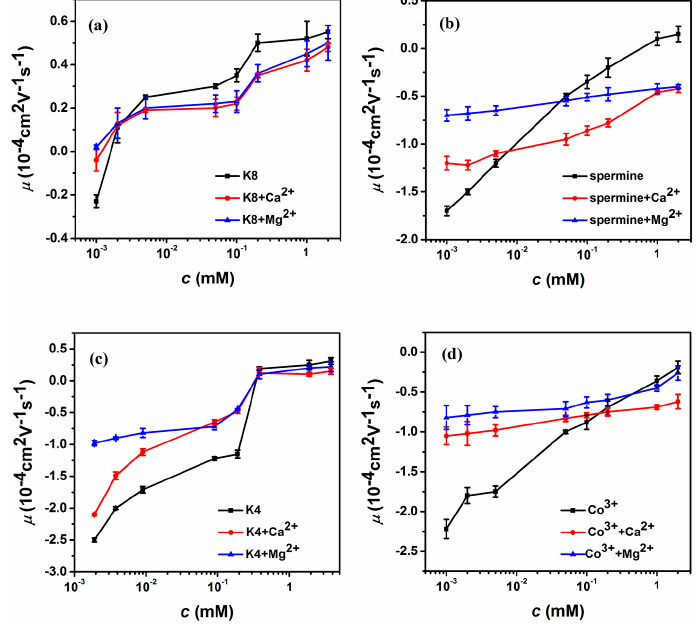
Figure 3. Electrophoretic mobility μ of condensed DNA as a function of the multivalent ions containing di-valent ions (3 mM Ca 2+ , 3 mM Mg 2+ ) in 1 mM TRIS. ( a ) The EM as a function of K8, K8-Ca 2+ , K8-Mg 2+ . ( b ) The EM as a function of spermine, spermine-Ca 2+ , spermine-Mg 2+ . ( c ) The EM as a function of K4, K4-Ca 2+ , K4-Mg 2+ . ( d ) The EM as a function of Cobalt hexamine, Cobalt hexamine-Ca 2+ , Cobalt hexamine-Mg 2+ . Each data point is the average of three consecutive measurements with the corresponding standard deviation as the error.